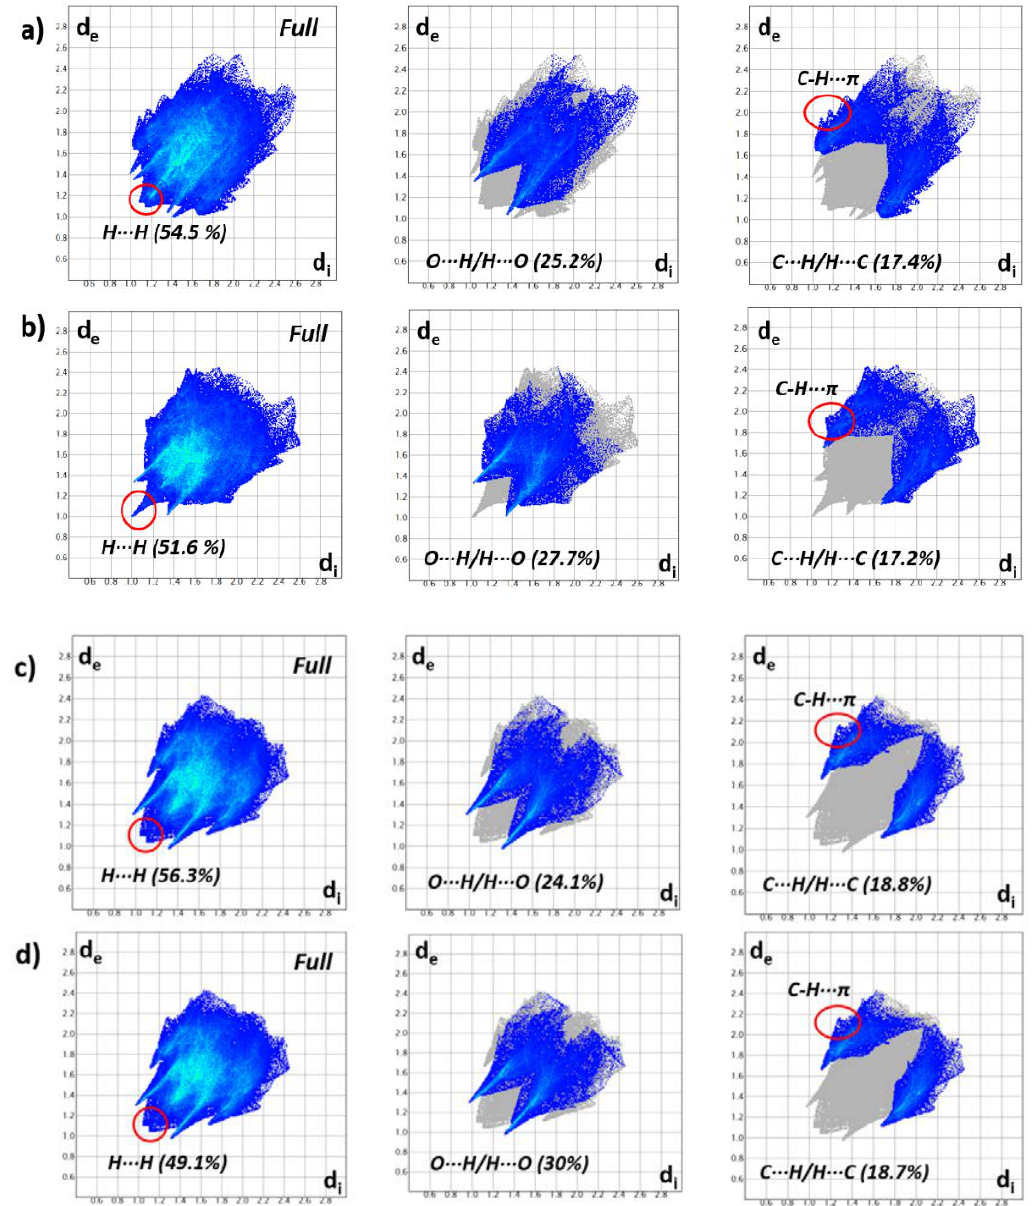
Figure 7. Full and decomposed 2D fingerprint plots for compounds: ( a ) 1 ; ( b ) 2 ; ( c ) 3 and (d) 4.